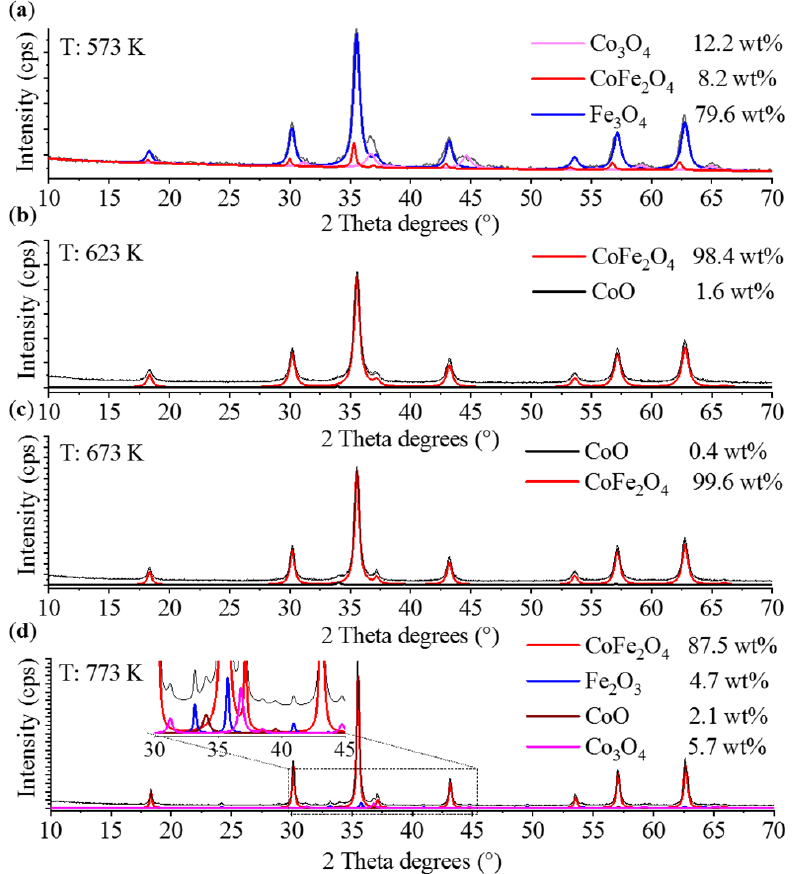
Figure 3. Rietveld refined X-ray diffractograms of the cobalt ferrite samples formed at different tem- peratures. ( a ) 573 K, ( b ) 632 K, ( c ) 673 K, ( d ) 773 K.